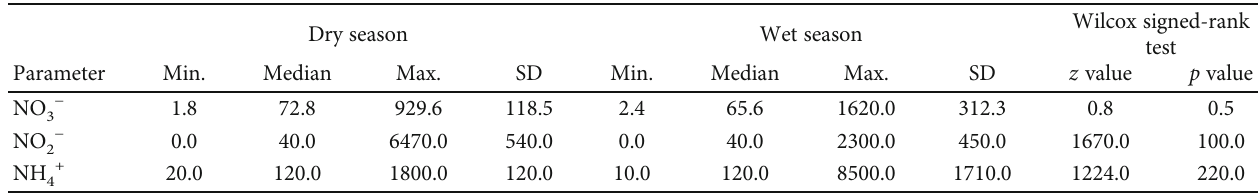
− , NO − , and NH 4+ in boreholes and shallow wells 3 2